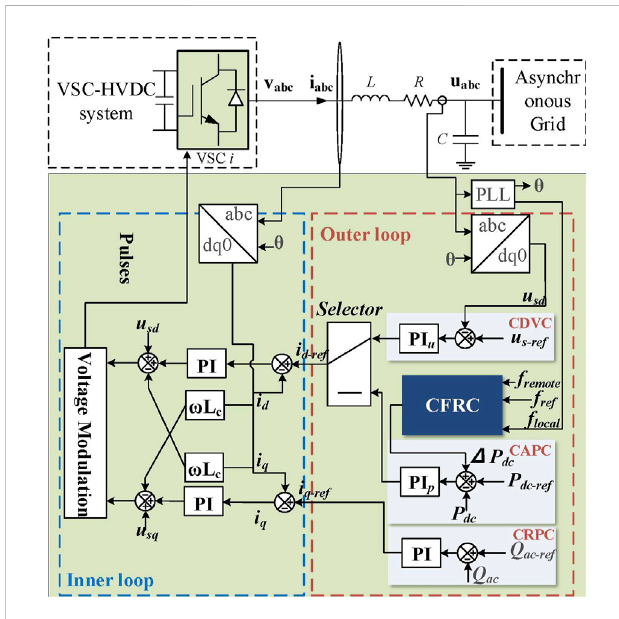
FIGURE 3 Basic control of the VSC-HVDC system (one